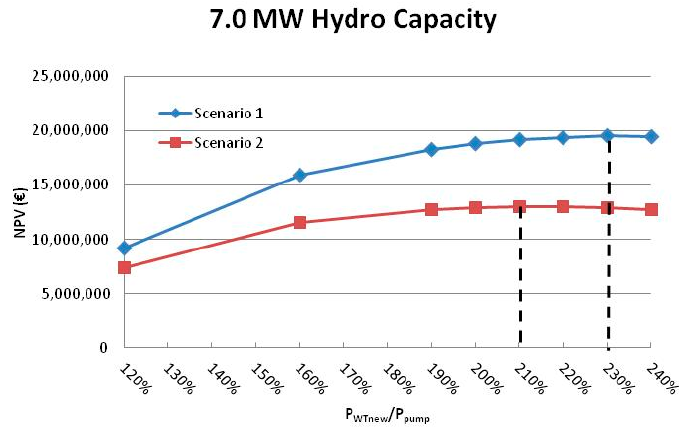
Figure 7. Comparison of the two billing scenarios considering P hydro = 7.0 MW.